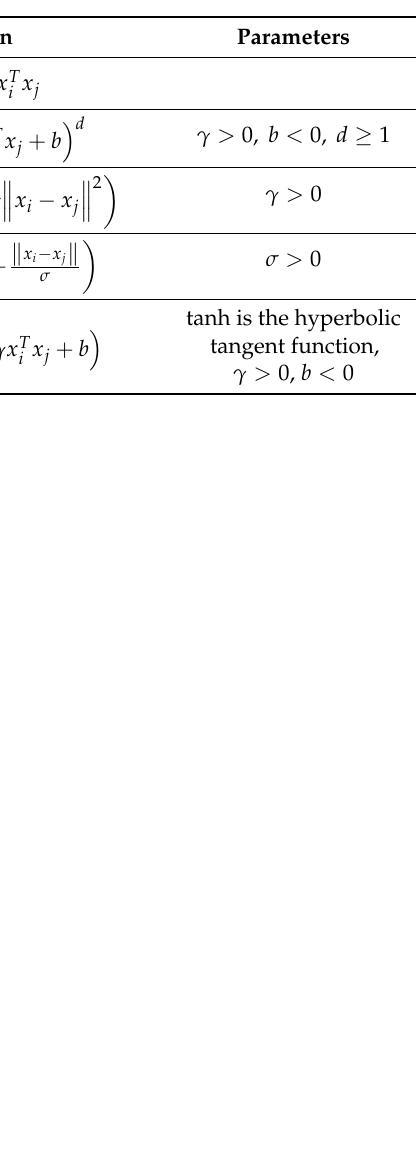
Table 1. Some common kernel functions.